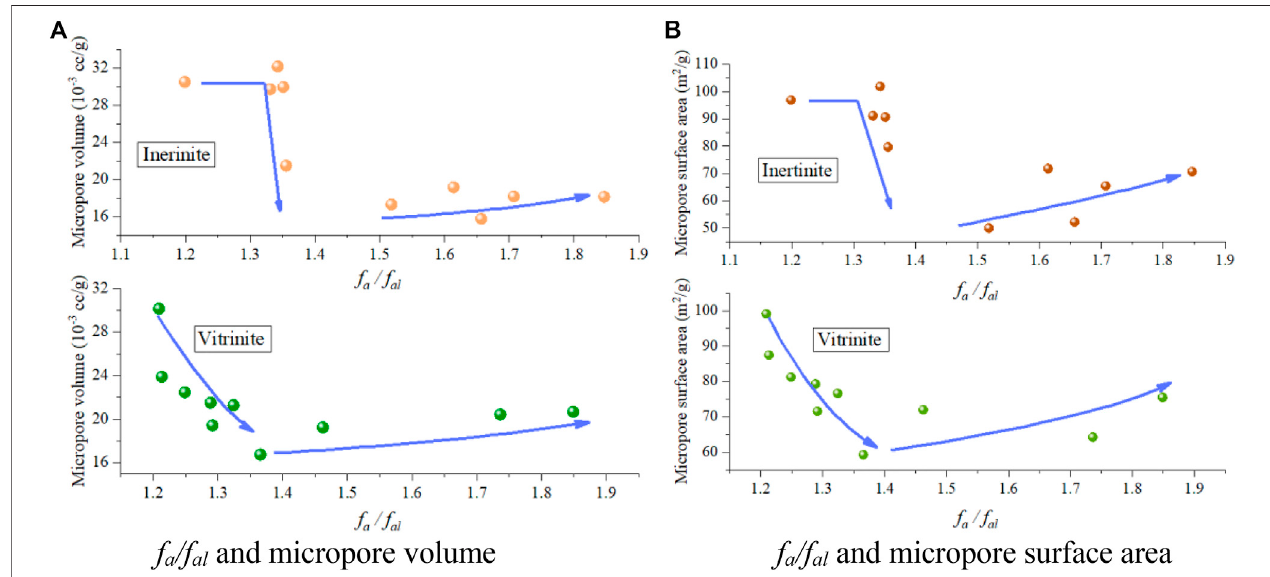
FIGURE 11 | f a /f al and micropore structures. f a /f al and micropore volume (A) , f a /f al and micropore surface area (B) .